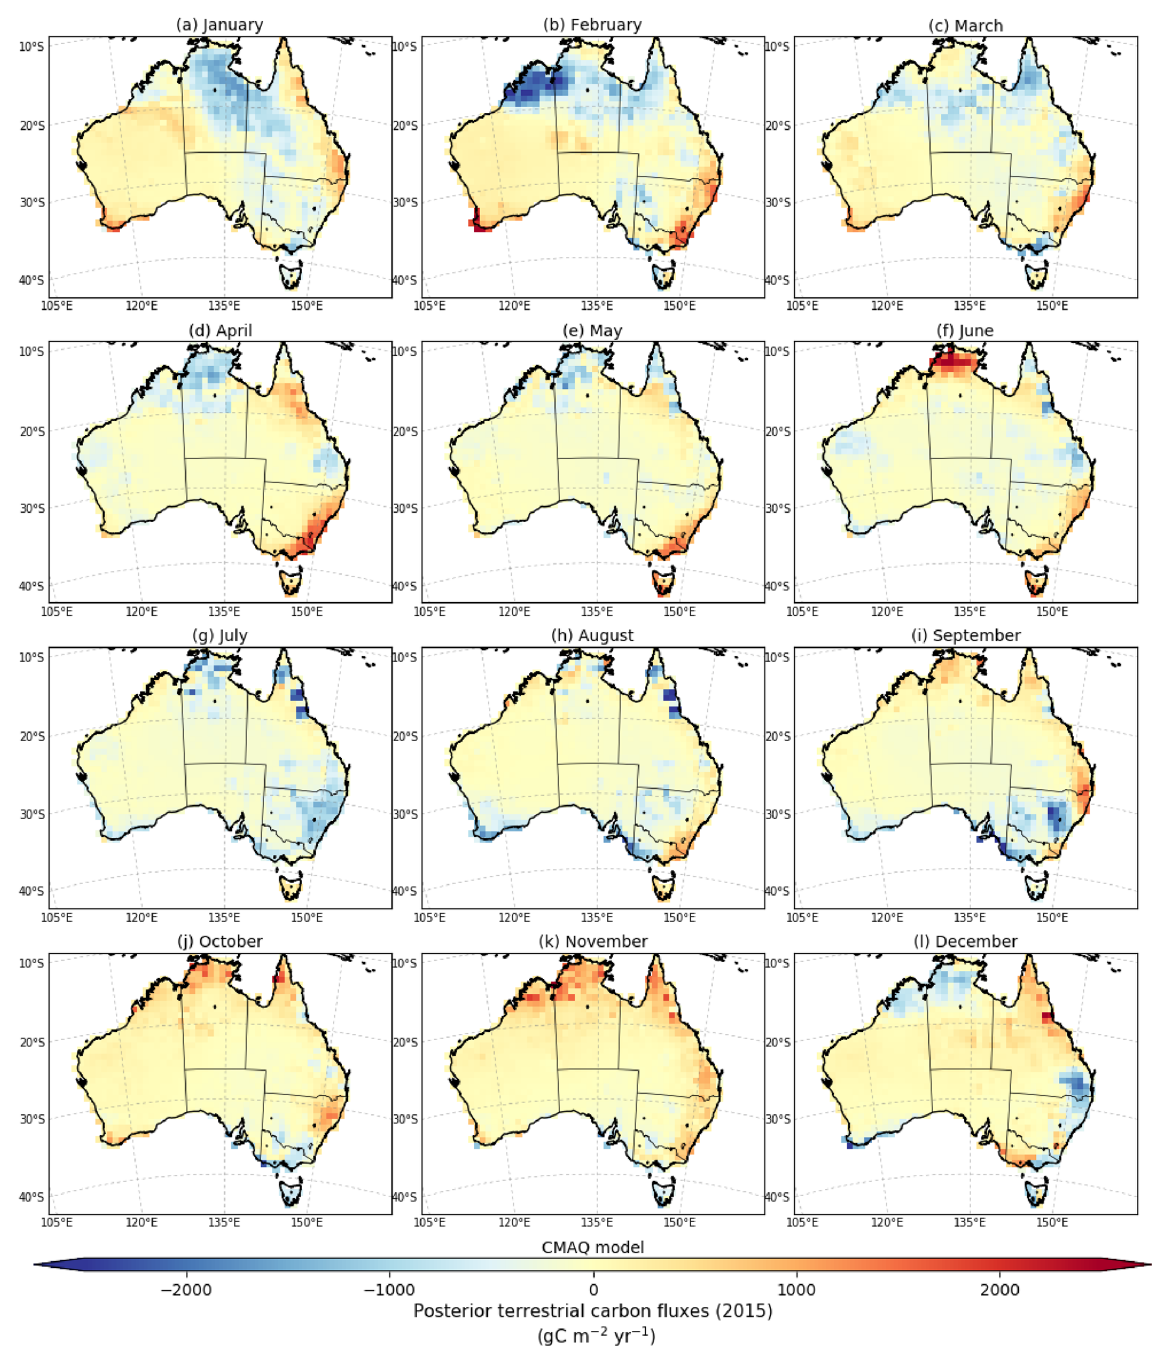
Figure 7. Posterior fluxes assimilated using LNLG OCO-2 satellite observations for 2015 (fossil fuel emissions are